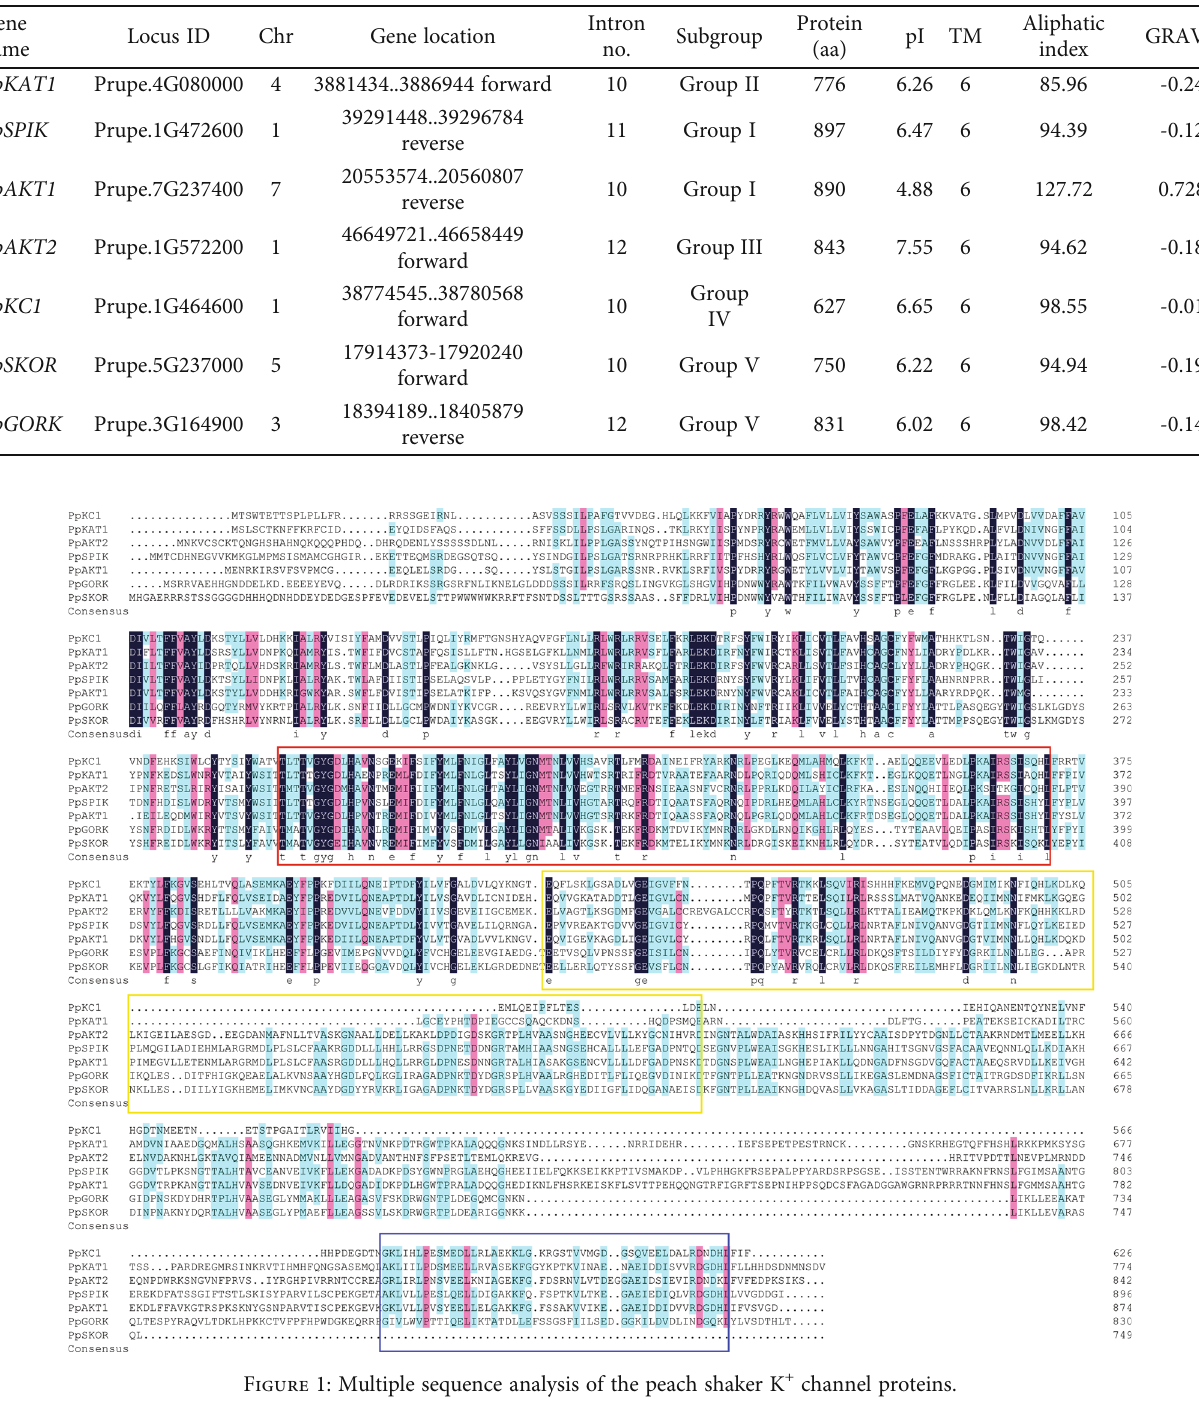
Table 1: Basic information of the peach shaker K + channel genes.